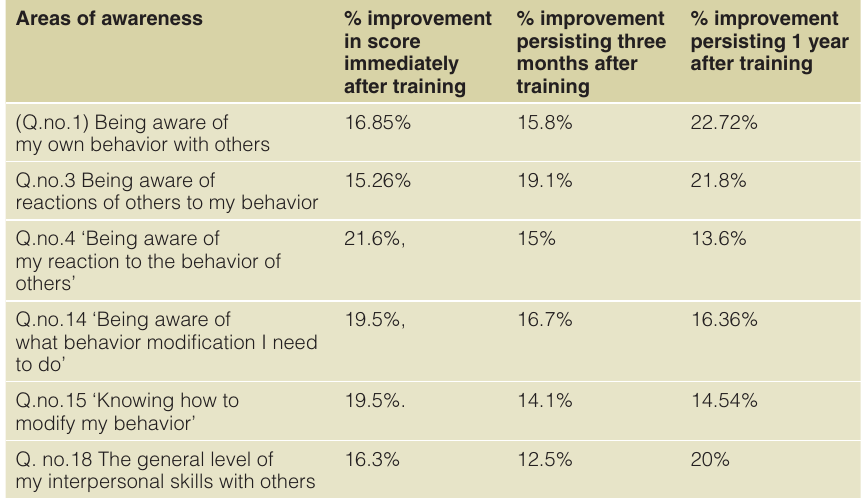
Table 3. Showing the areas of Personal Awareness showing greatest improvement in at different stages of assessment. (Q. no. of the assessment sheet). Areas of